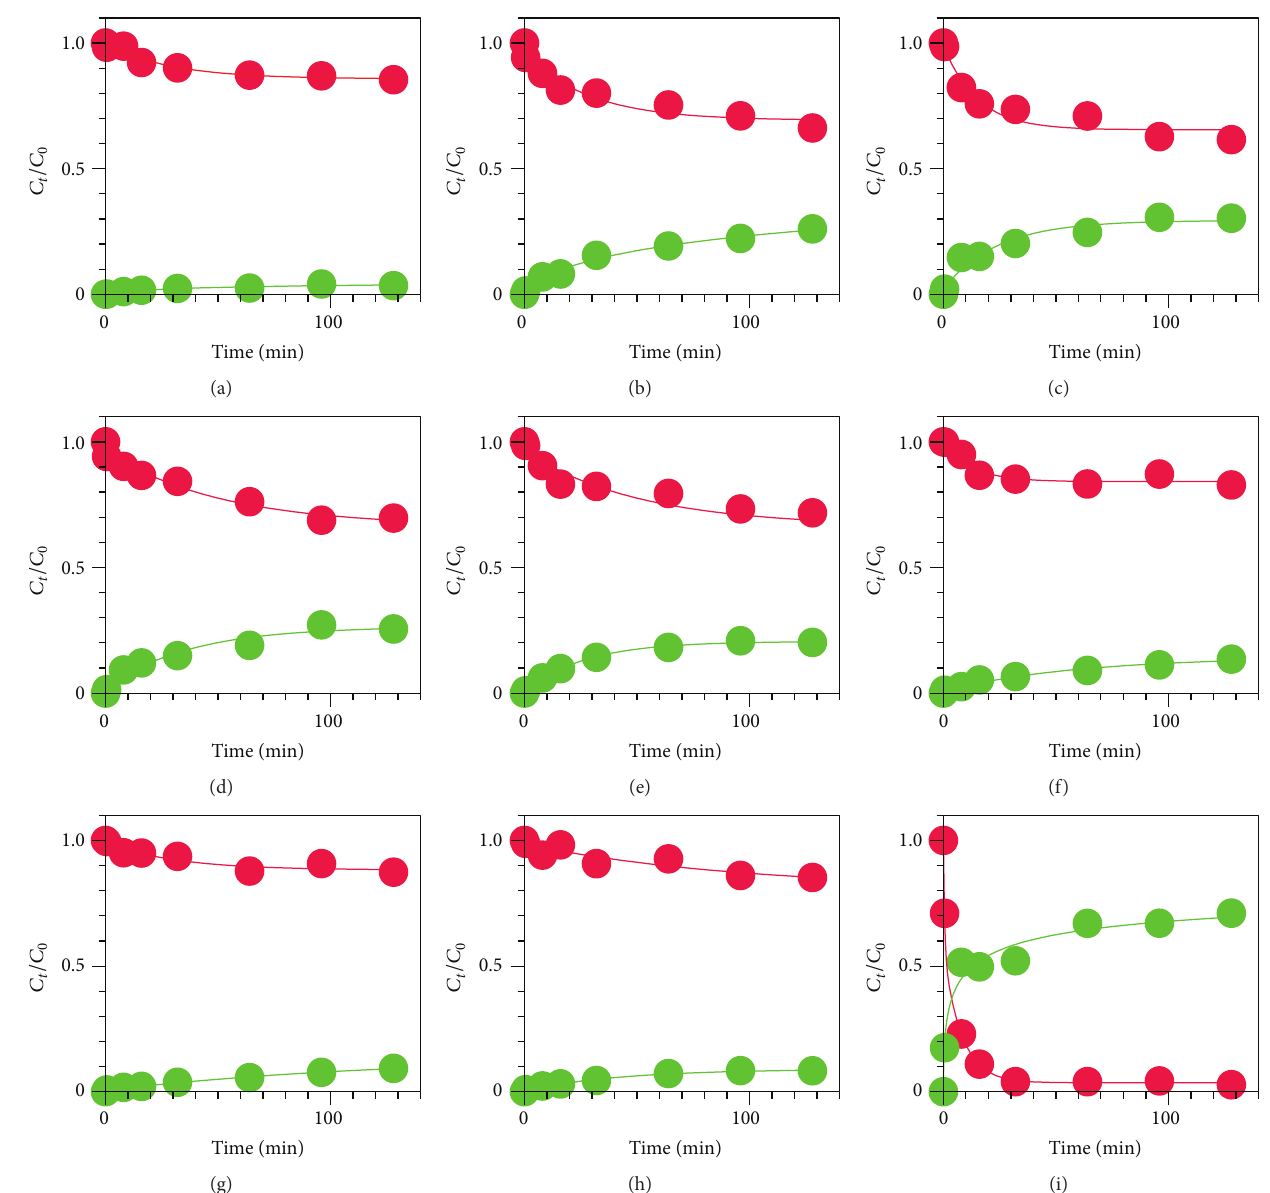
Figure 4: Time dependencies for the degradation of fenchlorphos on CeO 2 annealed at different temperatures. Recovered cerium oxide annealed at temperature (a) 200 ∘ C; (b) 300 ∘ C; (c) 400 ∘ C; (d) 500 ∘ C; (e) 600 ∘ C; (f) 700 ∘ C; (g) 800 ∘ C; (h) 900 ∘ C. (i) Pure cerium oxide annealed at 400 ∘